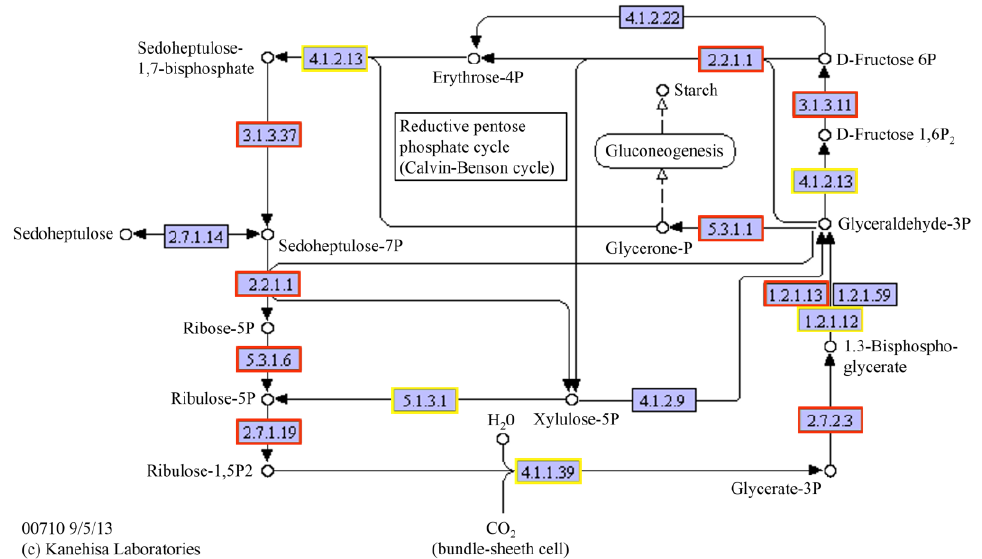
Figure 17. Reductive pentose phosphate cycle pathway in P. kessleri FACHB-3316 generated by KEGG. (The red boxes indicate the ko nodes containing the up-regulated differential gene enzymes; the orange boxes indicate the ko nodes containing up- and down-regulated differential gene en- zymes.).